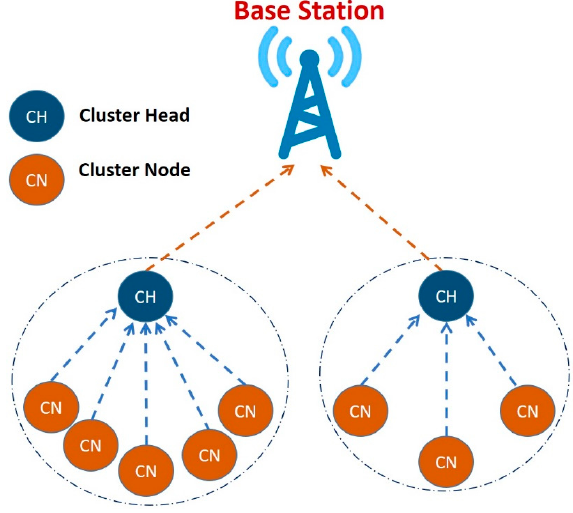
Figure 1. LEACH protocol topology.